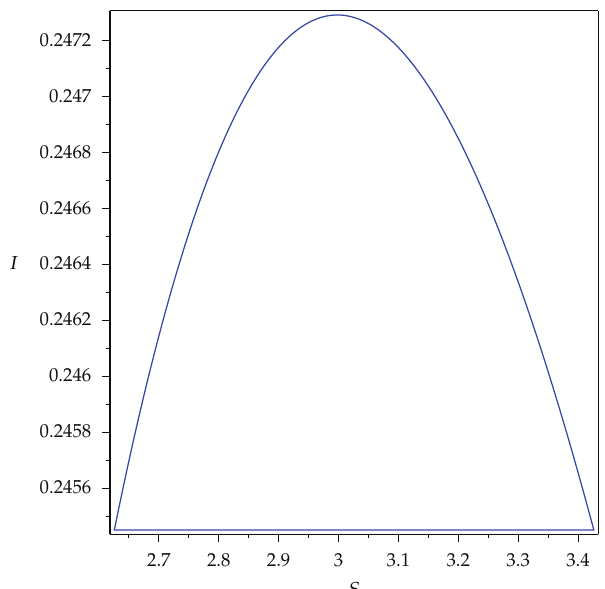
Figure 12: Phase diagram of S (cid:3) t (cid:4) and I (cid:3) t (cid:4) with parameters ρ (cid:7) 0 . 3 , μ (cid:7) 0 . 2 , β (cid:7) 1 . 2 , α (cid:7) 1 , r (cid:7) 0 . 6 , d (cid:7) 0 . 2 , ω (cid:7) 0 . 1 , T (cid:7) 1 , and τ (cid:7) 0.